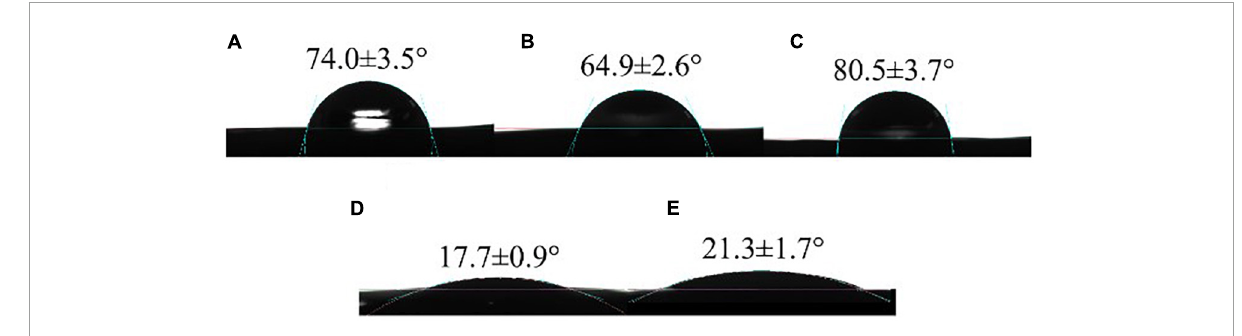
FIGURE4 Water contact angles of CS (A) , CS/WPI (B) , CS/WPI/WPEO (C) , CS/WPI/TiO 2 (D) , and CS/WPI/WPEO/TiO 2 (E) films.